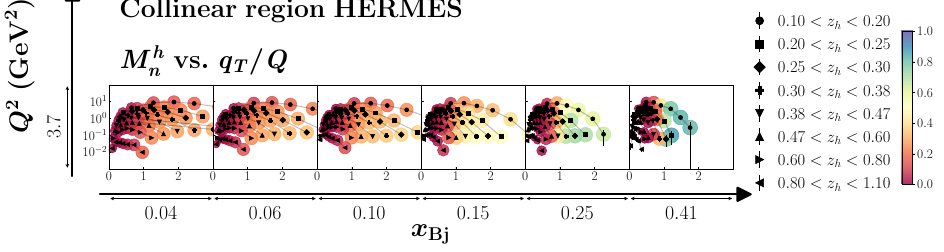
Figure 11 . Affinity to the collinear region for the HERMES multiplicity data [46].